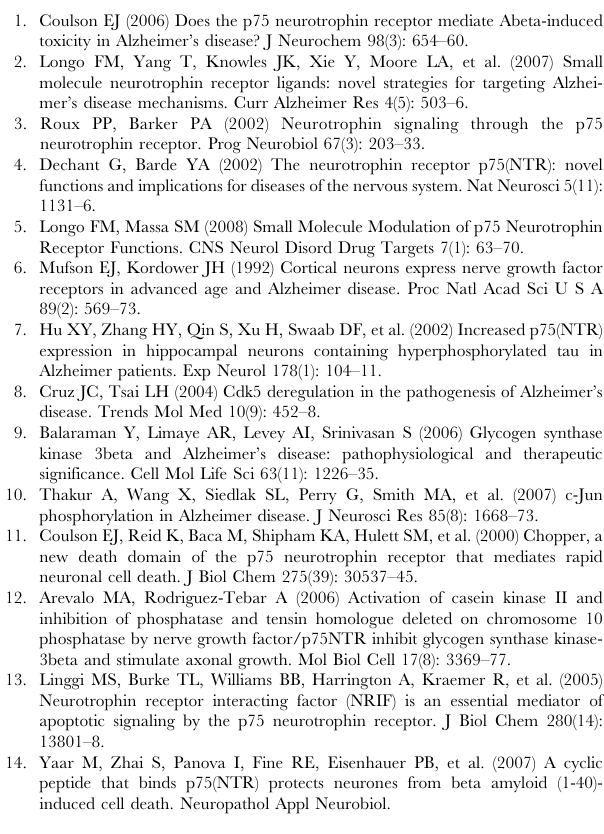
Table S1 Cerep receptor screen. Compound LM11A-31 was submitted to Cerep Inc. (Seattle, WA) and applied to the ExpresSProfile receptor screen. Values shown indicate the percent by which binding of a control ligand is inhibited by the test compound. Inhibition of binding by , 20% is interpreted as no significant binding